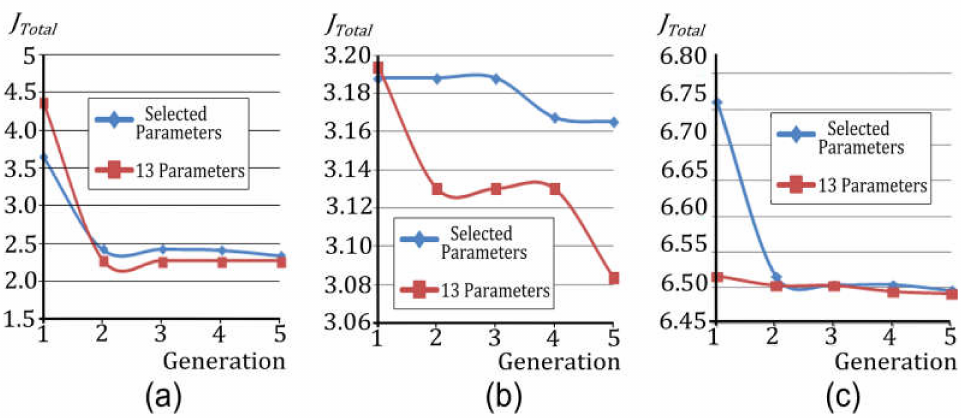
Figure 8. Development of objective function J Total for: ( a ) First welded joint FE model; ( b ) Second welded joint FE model; and, ( c ) Third welded joint FE models proposed considering the same level of importance ( w Temp = 1 and w Dist =